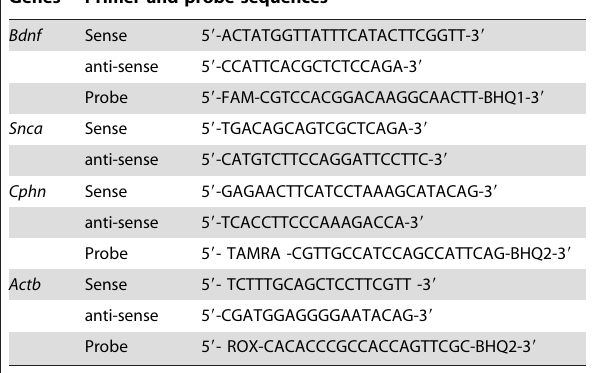
Genes Primer and probe